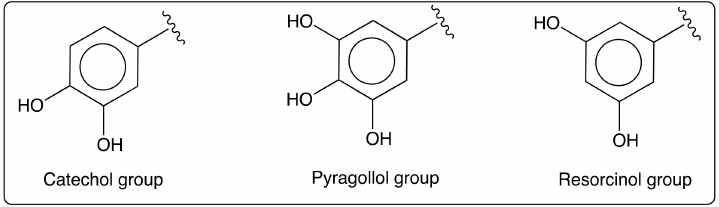
Figure 10. Catechol, pyrogallol and resorcinol groups